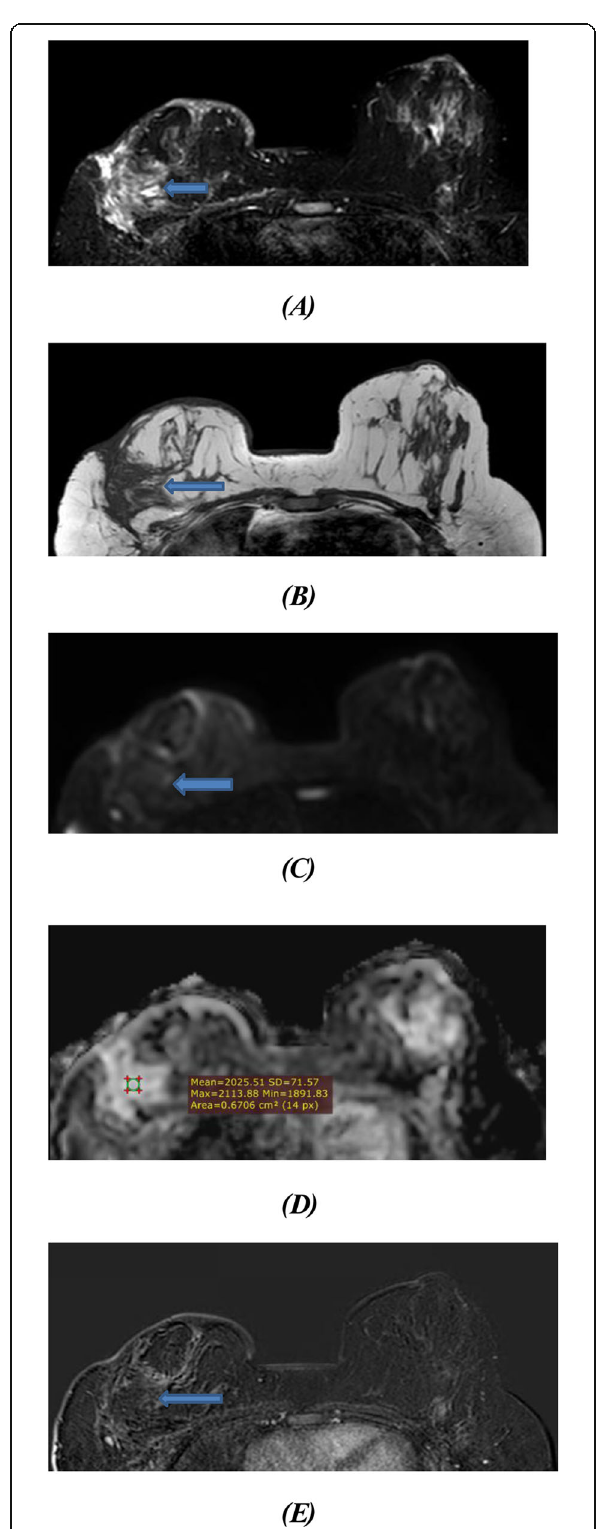
Fig. 4 Female patient aged 36 years with history of right breast cancer underwent conservative breast surgery and then presented by palpable right breast mass. a Axial STIR image showed irregular shaped right breast lesion of intermediate to high signal intensity. b Axial T1WI, the lesion appeared of low signal intensity. c , d DWI and ADC map, the lesion appeared free on diffusion with a mean ADC value = 2 × 10 – 3 mm 2 /s. e Subtraction MR image, the lesion showed no significant enhancement. Pathological diagnosis revealed post-operative fibrosis and scar